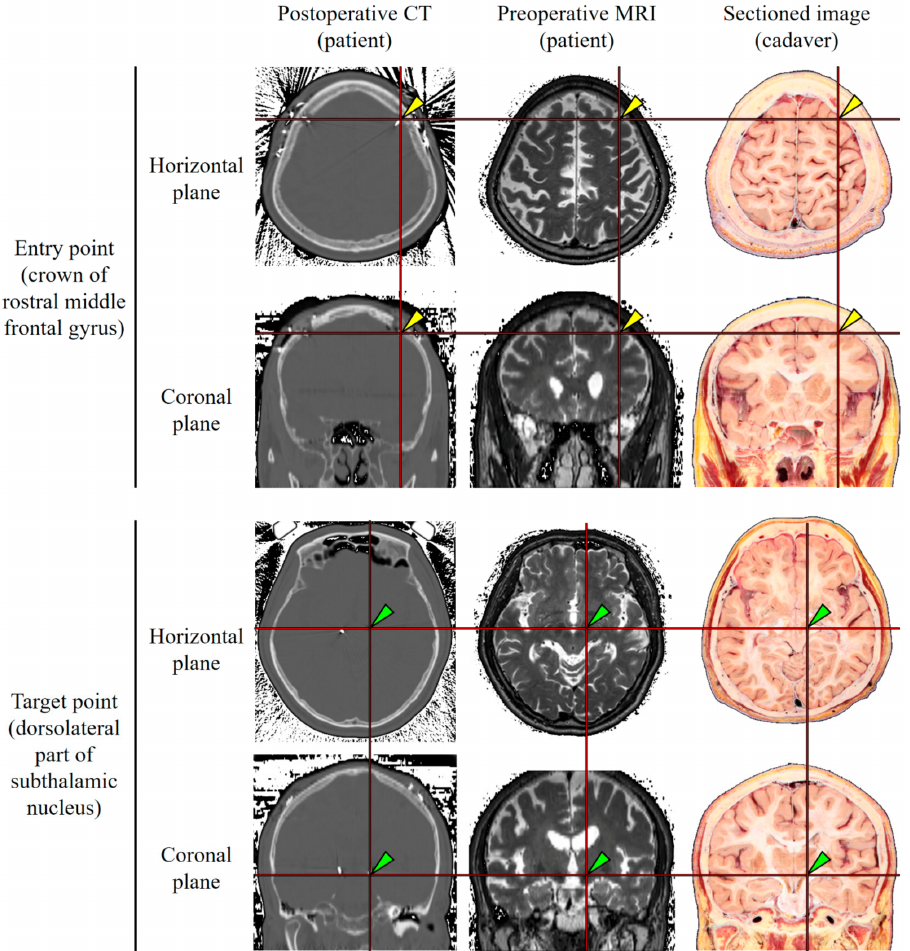
Figure 1. Entry point (yellow arrow head) and target point (green arrow head) of DBS. The entry point and target point acquired from the post-operative CT of a DBS patient as a representative were applied to the pre-operative MRI of a DBS patient through registration. The entry point and target point on the pre-operative MRI of a DBS patient were applied to the sectioned images of a cadaver by comparing the anatomy of the brain